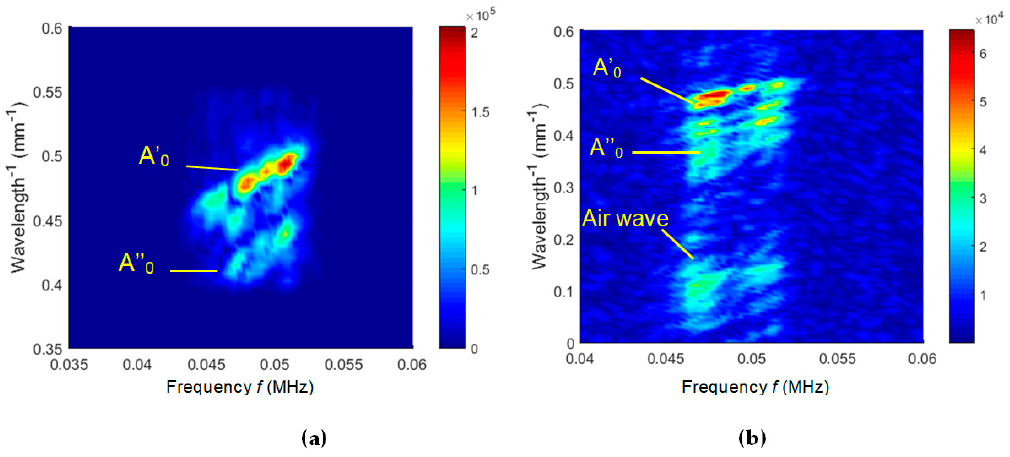
Figure 22. 2D spectra of the contact ( a ) and of the air-coupled B-scans ( b ).